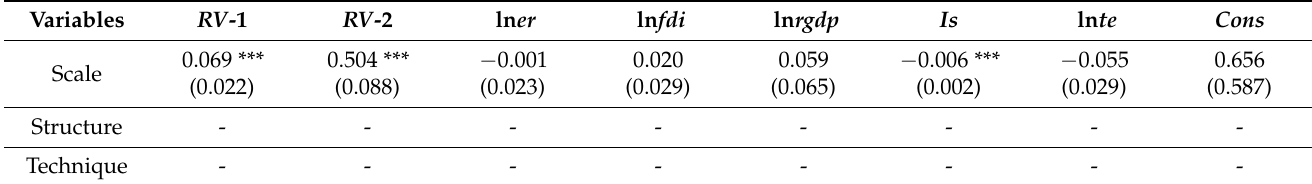
Table 4. Regression results of the threshold effect of various variables for related variety of knowledge on the efficiency of urban green innovation.